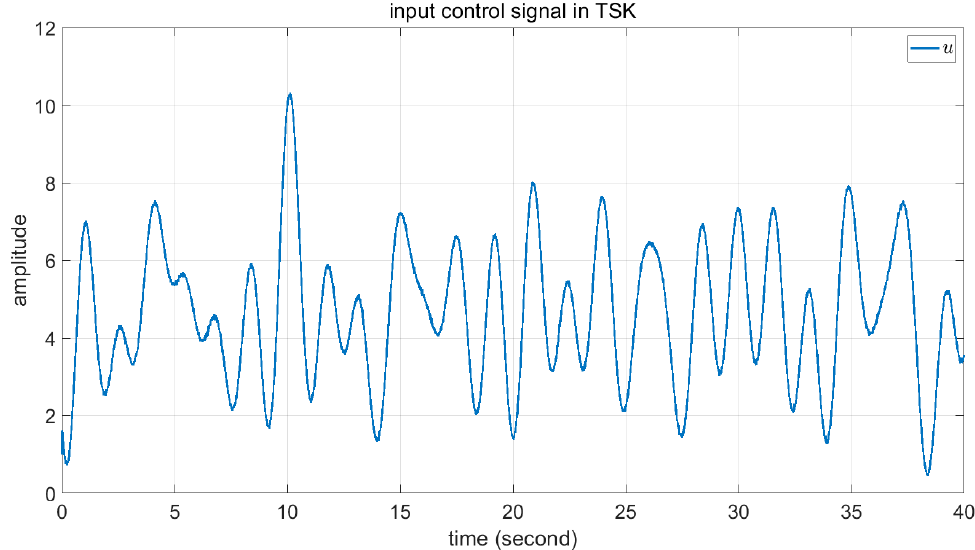
Figure 16. Angular velocity of the rotor in fuzzy TSK.